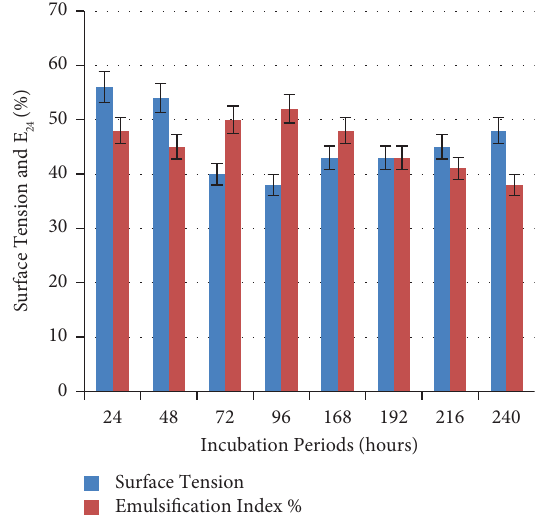
Figure 12: Efect of diferent incubation periods on biosurfactant production. 96 h was considered as the optimal incubation period for biosurfactant harvesting in P. guguanensis strain Iraqi ZG.K.M.